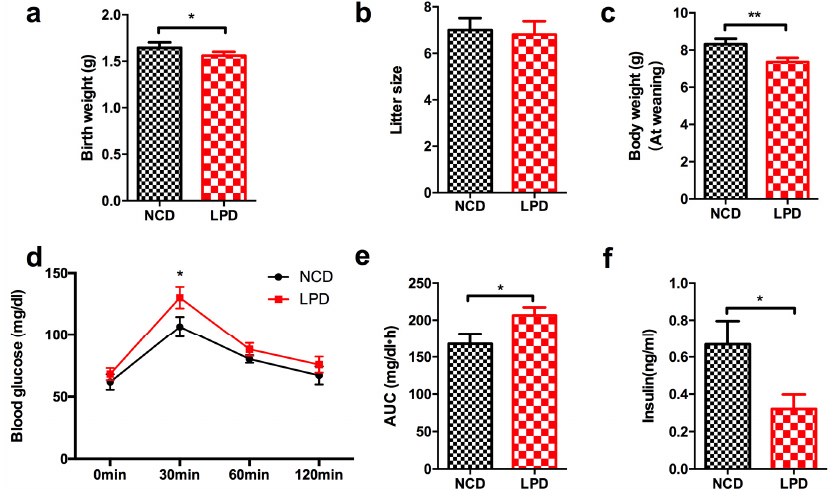
Figure 2. Metabolic profile and serum insulin concentration in offspring at weaning. ( a ) Birth weight; ( b ) litter size; ( c ) body weight at weaning; ( d ) intraperitoneal glucose tolerance test; ( e ) area under curve (AUC) of glucose tolerance test; and ( f ) serum insulin level. Data represented as the mean ± SEM ( n = 6 to 8, per group). * p < 0.05, ** p < 0.01 vs. the NCD group. LPD, low ‐ protein diet; NCD, normal chow diet.